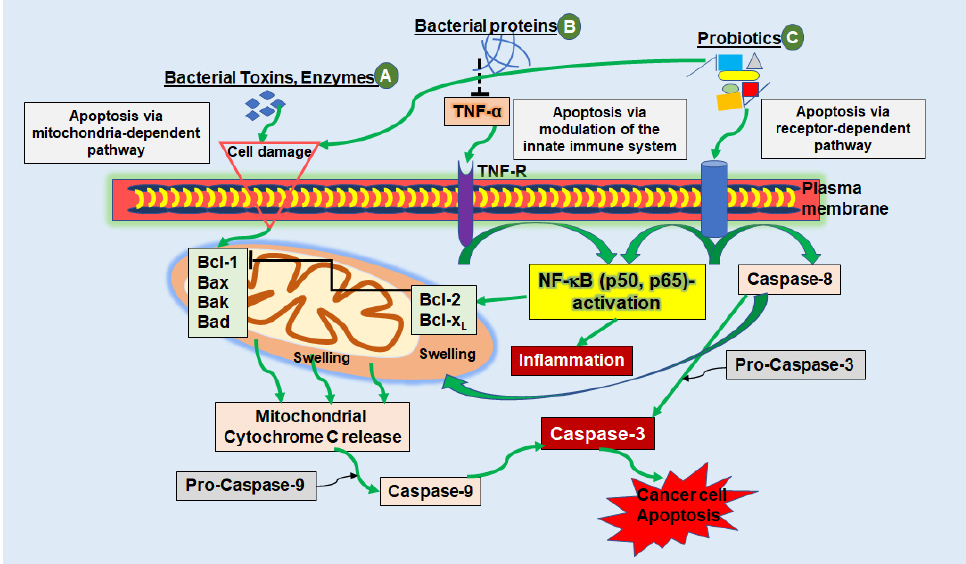
Figure 1. Schematic diagram showing the mechanisms of apoptosis triggered by bacterial peptides in cancer cells. ( A ) Bacterial toxins, secreted by various bacterial strains can cause apoptosis via the mitochondria-dependent pathway by causing cell injury, for example, by cell membrane pore formation. Induction of the intrinsic pathway leads to activation of pro-apoptotic proteins (Bcl-1, Bad, Bax, Bak), which in turn stimulates the release of cytochrome c molecules from the mitochondrial intermembrane space into the cytosol. Cytochrome c, together with Caspase-9 forms a complex called the “apoptosome”, finally stimulating executioner caspases (e.g., Caspase-3) leading to cancer cell apoptosis. ( B ) Bacterial proteins and peptides can have a modulatory impact on cytokines such as TNF- α , resulting in activation or blockage of NF- κ B. With suppression of NF- κ B, which stimulates anti-apoptotic proteins Bcl-2 and Bcl-xL, which in turn regulates apoptosis by blocking cytochrome c release, pro-apoptotic Bax and Bak-proteins remain stimulated and apoptosis is induced. ( C ) Besides stimulating the intrinsic pathway of apoptosis, probiotics are capable of apoptosis induction through stimulation of the extrinsic receptor-dependent pathway. Here, so called cell death receptors, such as TNF-R, bind to natural ligands, whereby initiator Caspase-8 and -10 are activated to cleave further downstream caspases, such as Caspase-3, which in turn induces cell apoptosis